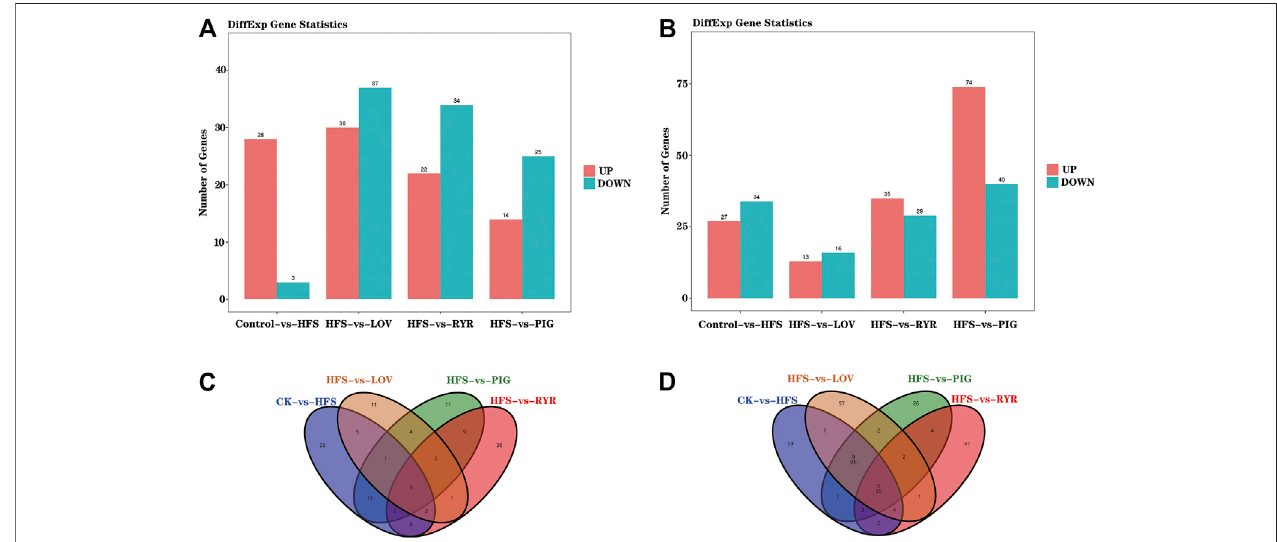
FIGURE 4 | A) Statistical histogram of differential genes between samples; (B) Statistical histogram of differential metabolites (In (A) and (B) , the x-coordinate is samples compared in pairs, and the vertical table is the number of differentially expressed genes or metabolites; Green and red represent differentially expressed genes or metabolites that are down-regulated and up-regulated, respectively); (C) Venn diagram showing the differentially expressed genes shared by the mice from each group; (D) Venn diagram showing the differentially expressed metabolites shared by the mice from each group (n (cid:2) 3).